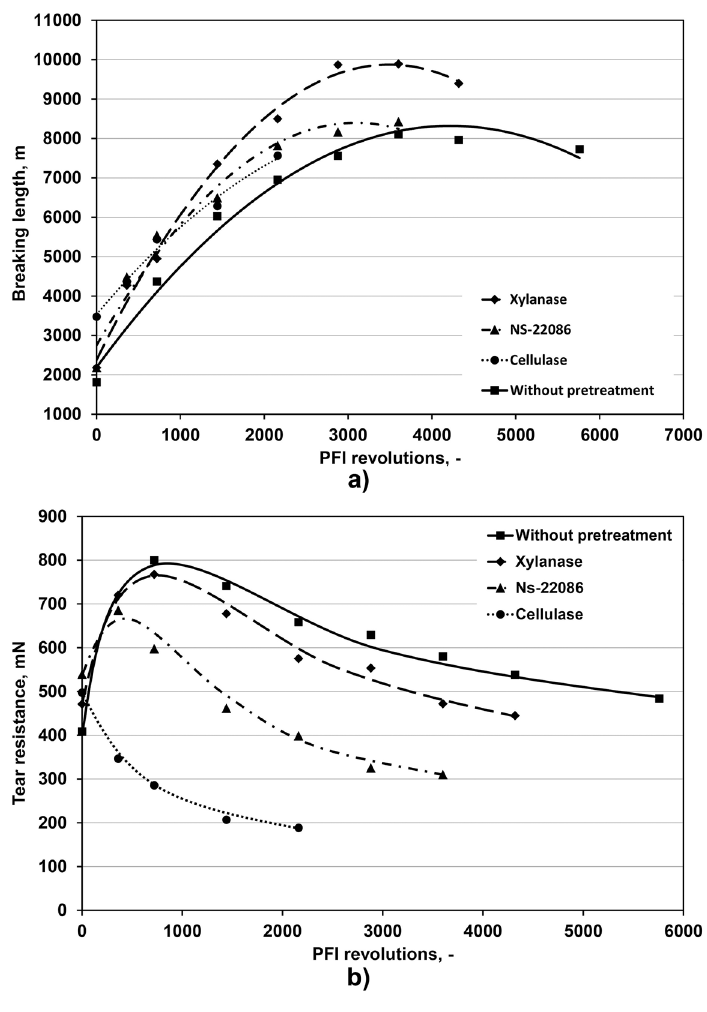
Fig 3. Effects of enzyme treatment and PFI mill revolutions number on breaking length (a) and tear resistance (b) of paper.